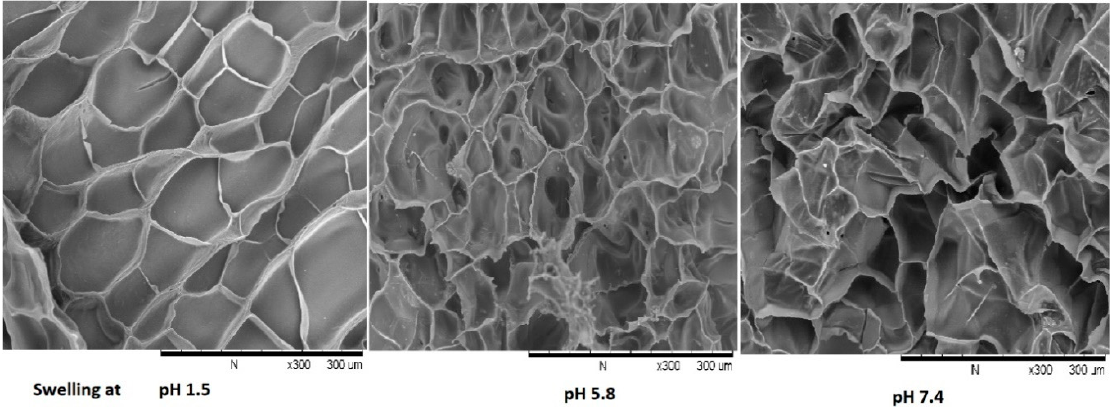
Figure 8. SEM images of the hydrogel at different pH (1.5, 5.8, 7.4) at magnification 300×.